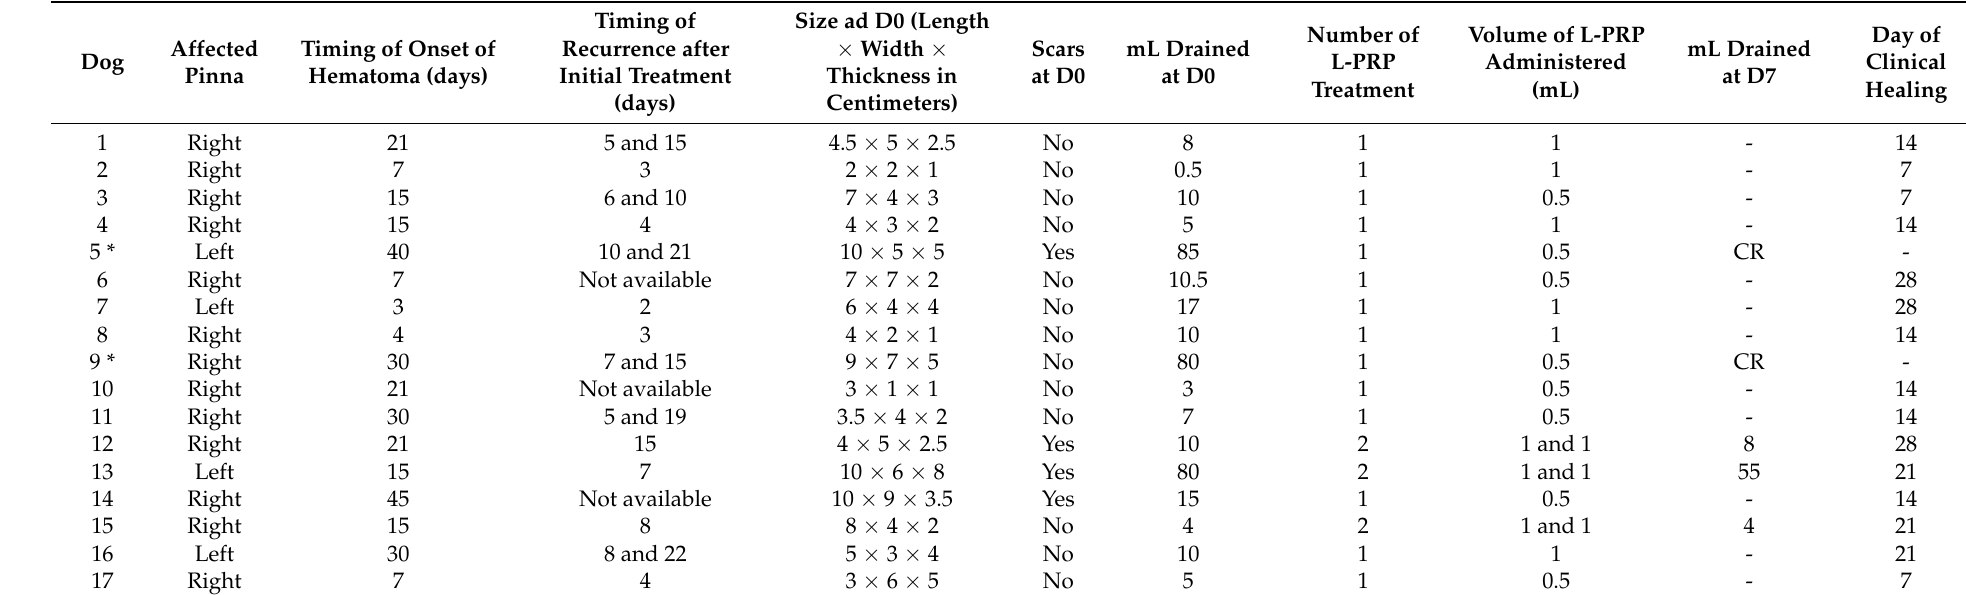
Table 2. Descriptive data of each aural hematoma at D0. The dogs marked with (*) did not complete the clinical